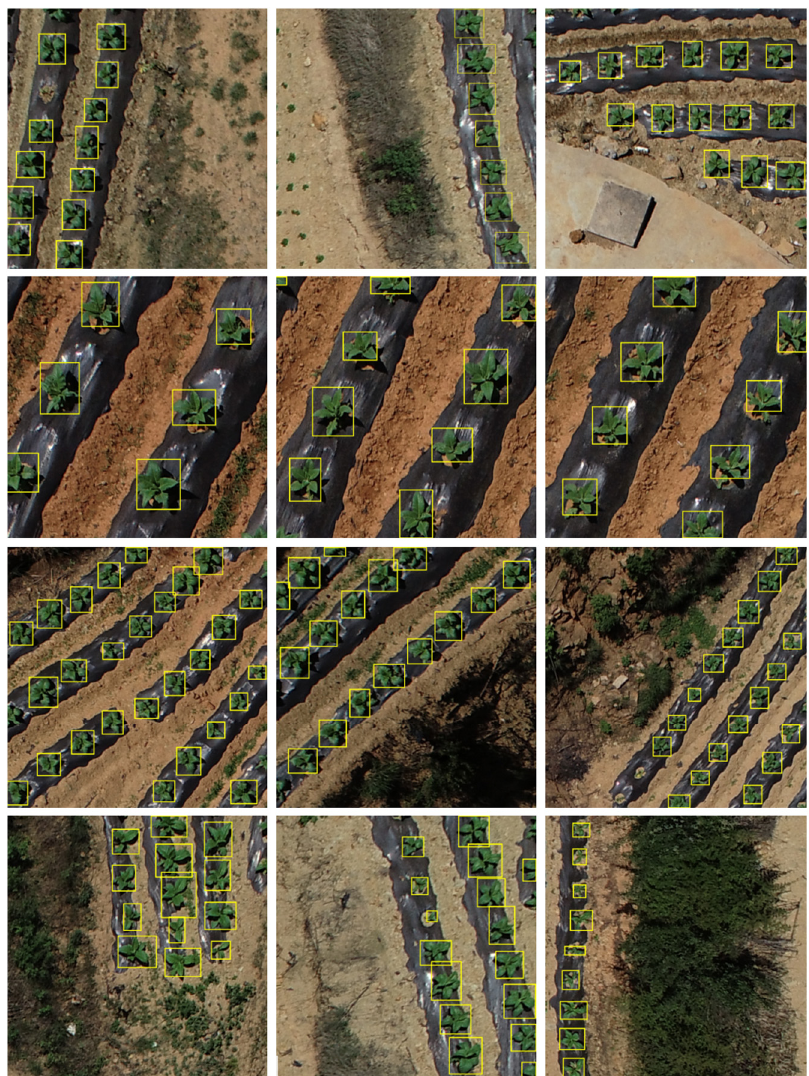
Figure 10. Visualization of some results in different datasets.